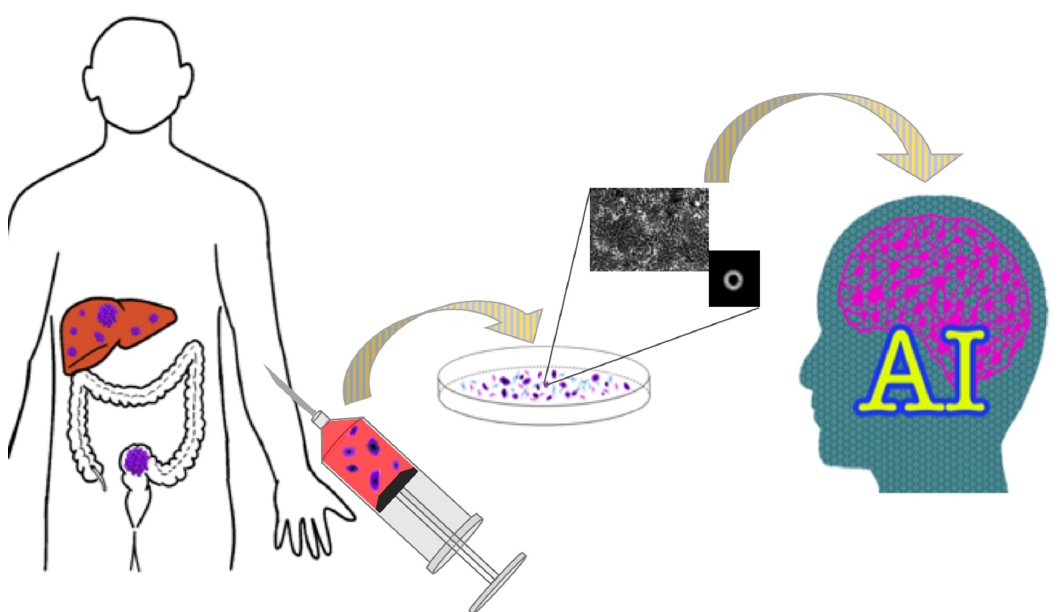
Figure 5. Schematic diagram of colorectal cancer precision medicine using AI. Based on the circulating tumor cell (CTC) morphology detected in the liquid biopsies of patients with unresectable advanced colorectal cancer, the presence or absence of anticancer drug resistance is determined by image recognition technology, using deep